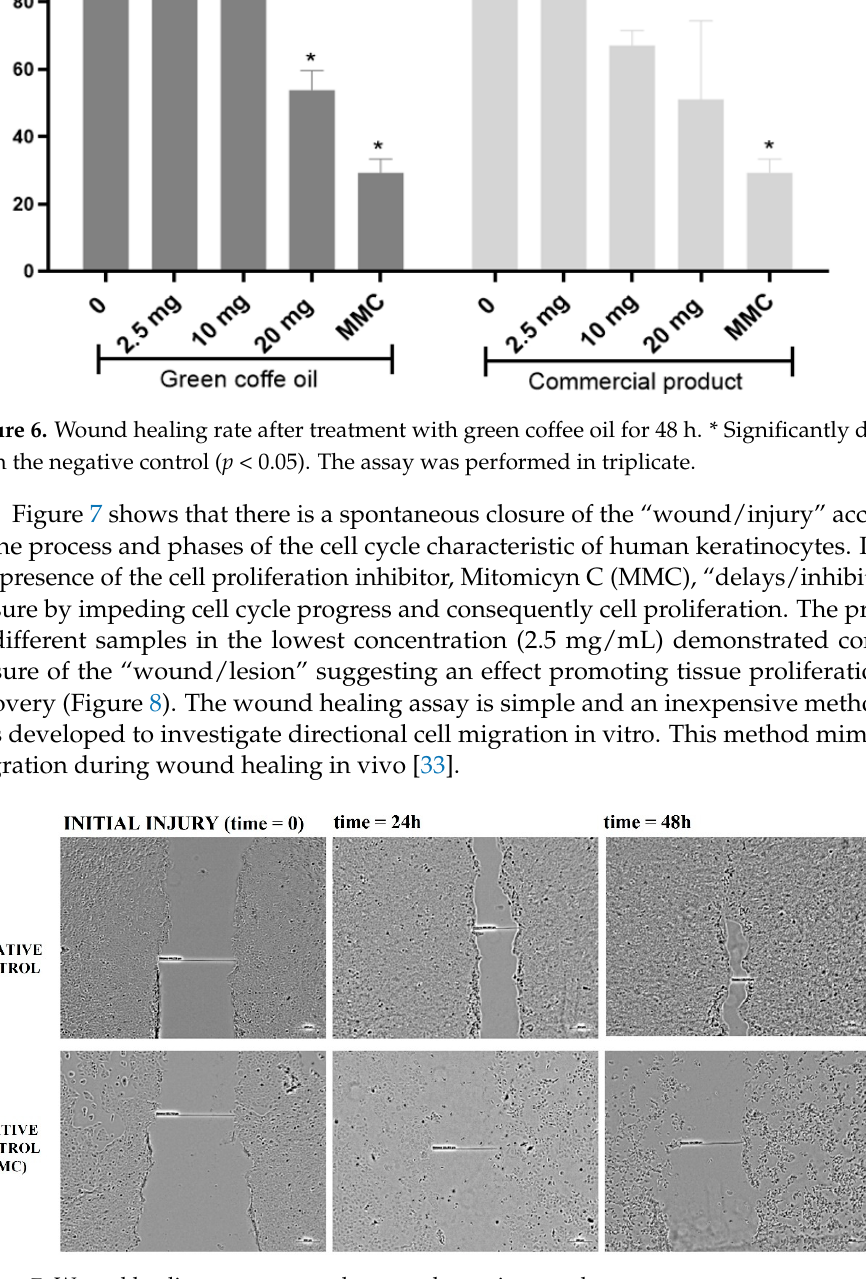
Figure 5. Cell survival fractions observed in human keratinocytes after 24 h of treatment with dif- ferent concentrations of green co ff ee oil. * Signi fi cantly di ff erent from the negative control ( p < 0.05). The assay was performed in triplicate.